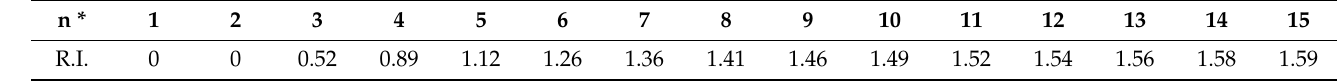
Table 6. The average random consistency index (R.I.) values.